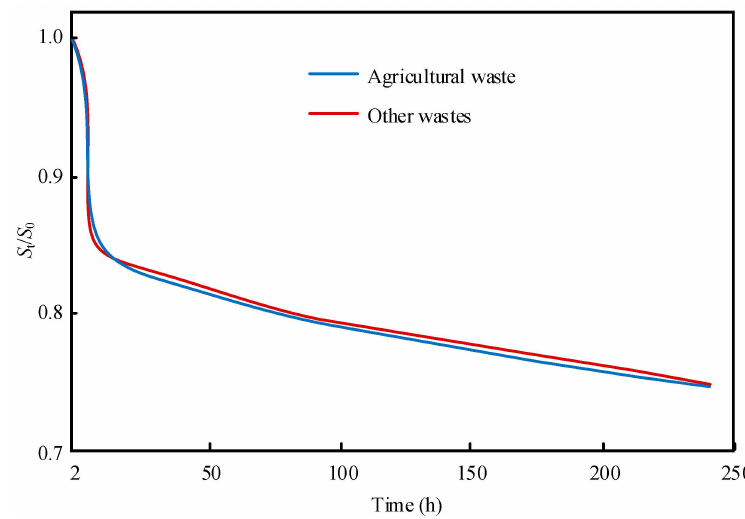
Figure 4. Comparison of biochar source